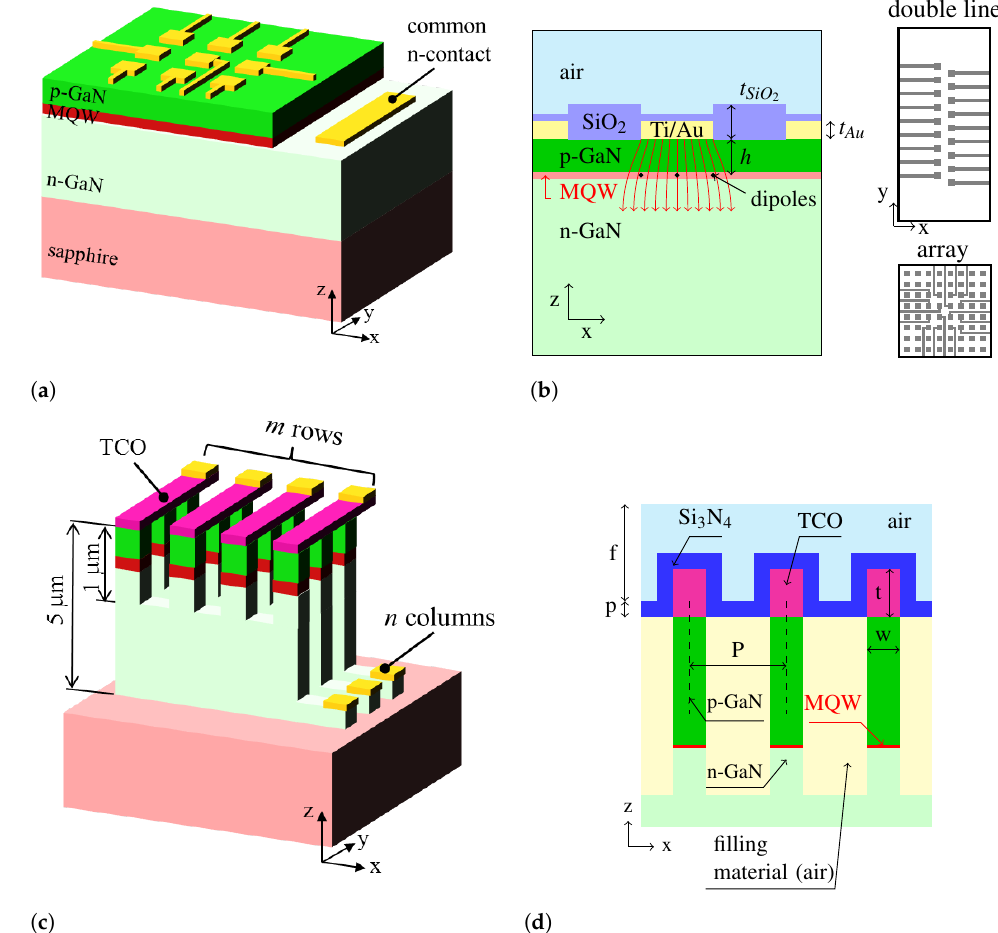
Figure 1. Scheme of the proposed nano-LED arrays. ( a ) The direct addressing scheme. Here, every pixel has its own p-side contact line (yellow), while the n-side contact is shared. A cross section is shown in ( b ), where the SiO 2 passivation layers are also indicated. Several point dipole sources are distributed over the emitting pixel area. The latter is determined by the current flow, indicated by the red arrows. We assume negligible in-plane current spreading. The two layouts studied in this work are depicted on the right. ( c ) The matrix addressing scheme. Here, a deep etching step completely isolates the different LED columns, while orthogonal p-side contact lines made from transparent n array. A cross section conductive oxide (TCO) are used for addressing the rows, resulting in an m × in the xz plane is shown in ( d ), indicating some of the structural parameters. The top 1 µ m of the structure is etched also between the TCO p-side contacts, for increased optical isolation. The size of the pixels and pitch of the arrays used in the modeling was the same for all designs and equals 200 200 nm 2 and 400 nm, respectively. The remaining parameters are the distance from source × dipole to top surface of GaN h = 100 nm, thickness of Ti/Au contact t Au = 50 nm, thickness of SiO 2 = 95 nm, thickness of TCO crossbars t = 150 nm and thickness of Si 3 N 4 layer p = 50 layer t SiO 2